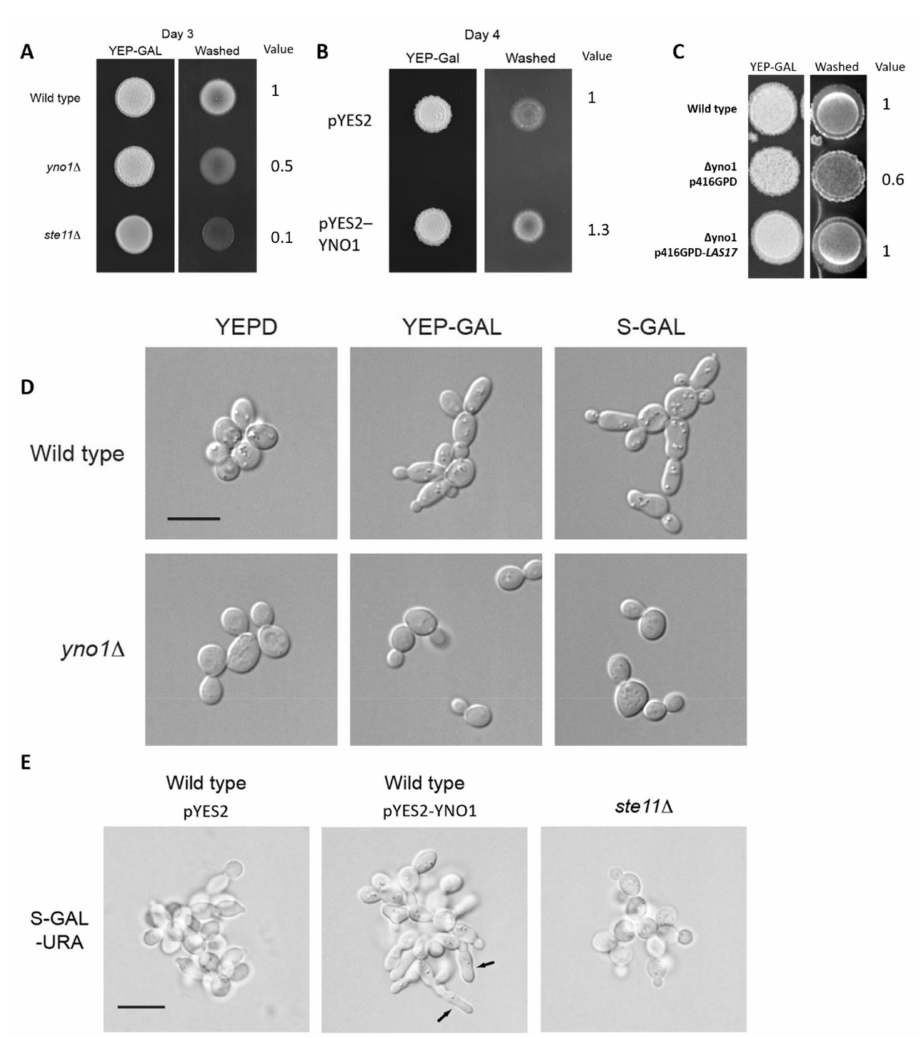
Figure 7. Evaluating the role of Yno1p in regulating filamentous growth. ( A ) Wild type cells (PC538), the ∆ yno1 mutant (PC7010), and the ∆ ste11 mutant (PC3861) in the ∑ 1278b strain background were spotted onto YEP-GAL media for 3 days at 30 ◦ C. The plate was photographed, washed in a stream of water, and photographed again. ( B ) Wild type Σ 1278b cells (PC538) harboring pYES2 or pYES2- YNO1 plasmids were grown on SC-Ura to maintain selection for the plasmids and spotted onto YEP-GAL media and incubated for 4 days at 30 ◦ C. The plate was photographed, washed in a stream of water and photographed again. ( C ) Wild type cells and the ∆ yno1 mutant either harboring p416GPD or p416GPD- LAS17 plasmids after selection on SC-Ura were spotted onto YEP-GAL media incubated for 4 days at 30 ◦ C. The plate wash assays (PWA) in ( A – C ) was repeated in multiple biological replicates and invasive growth was quantified using ImageJ. In ( A ), wild type invasion was set to a value of 1.0, which varied by ± 0.05 across trials. The invasive growth of the ∆ yno1 mutant was 0.55 ± 0.11, and ∆ ste11 was 0.1 ± 0.09 (N = 3, p < 0.03). In ( B ), wild type invasion was set to a value of 1.0, which varied by ± 0.12 across trials. The invasion of pYES-YNO1 was 1.42 ± 0.14 (N = 3, p < 0.01). In ( C ), the intensity of the spots after the PWA are indistinguishable between the wild type p416GPD and ∆ yno1 p416GPD- LAS17 cells and are reduced to 0.8 +/– 0.1 in the ∆ yno1 p416GPD mutant (N = 4; p = 0. p = 0.05). ( D ) Wild type cells (PC538) and the ∆ yno1 mutant (PC7010) were grown to mid-log phase in YEPD, YEP-GAL, or S-GAL media and examined by differential interference contrast (DIC) microscopy at 100X magnification. Bar, 10 microns. ( E ) Analysis of cells overexpressing YNO1 by the single cell invasive growth assay (Cullen and Sprague, 2000). Wild type cells (PC538) cells harboring pYES2 or pYES2- YNO1 were grown to saturation in liquid culture and spread onto SC-Ura medium. A spot of galactose (10 microliters of 20% galactose) was spotted onto the plate, which was incubated for 16 h at 30 ◦ C. Cells were examined by DIC microscopy on plates at 100X. Bar, 10 microns. Arrows mark several examples of hyper-polarized